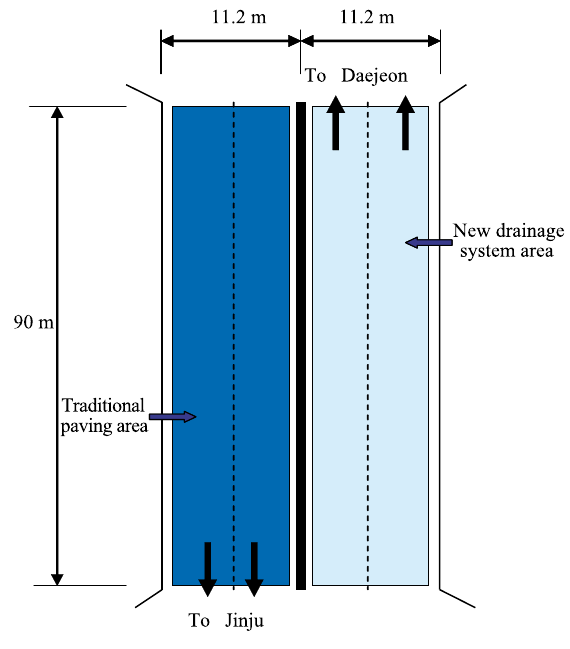
Fig. 7. Layouts of the in-field trial construction